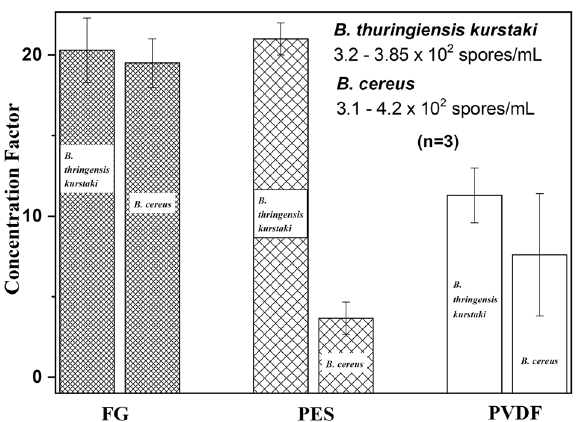
Figure 2. Concentration factors of B. thuringiensis kurstaki and B. cereus spores obtained with FG, PES, and PVDF filters for suspensions at initial concentration of 3.14.2 × 10 2 spores/mL. The data bars represent standard errors of the mean from three separate